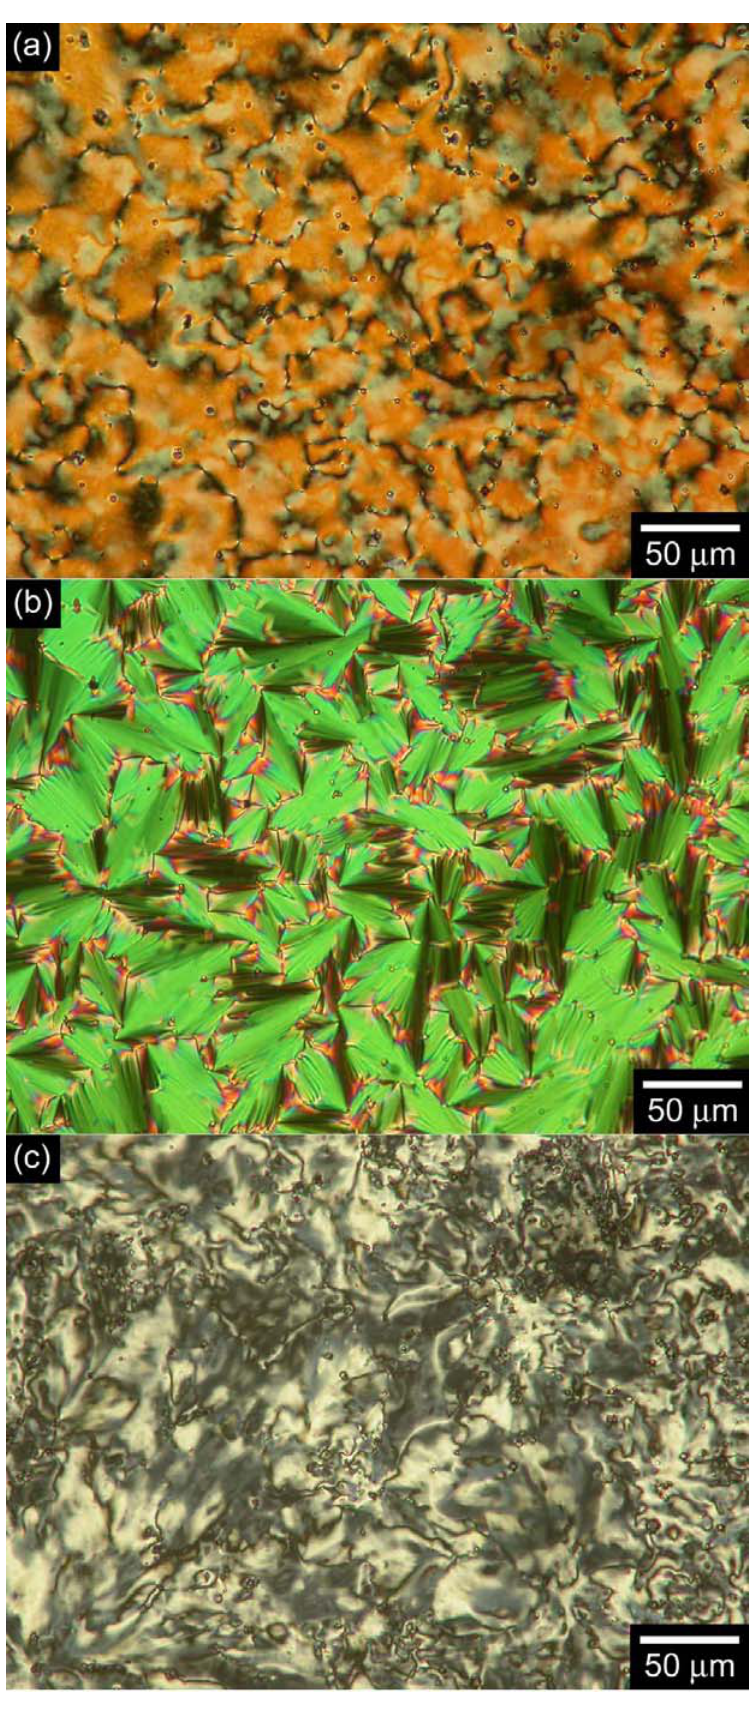
Figure 6. Polarizing optical microscopy (POM) images of LC phases of the monomer bearing LC moiety ( (a) : 103 °C, (b) : 94 °C, (c) : 83